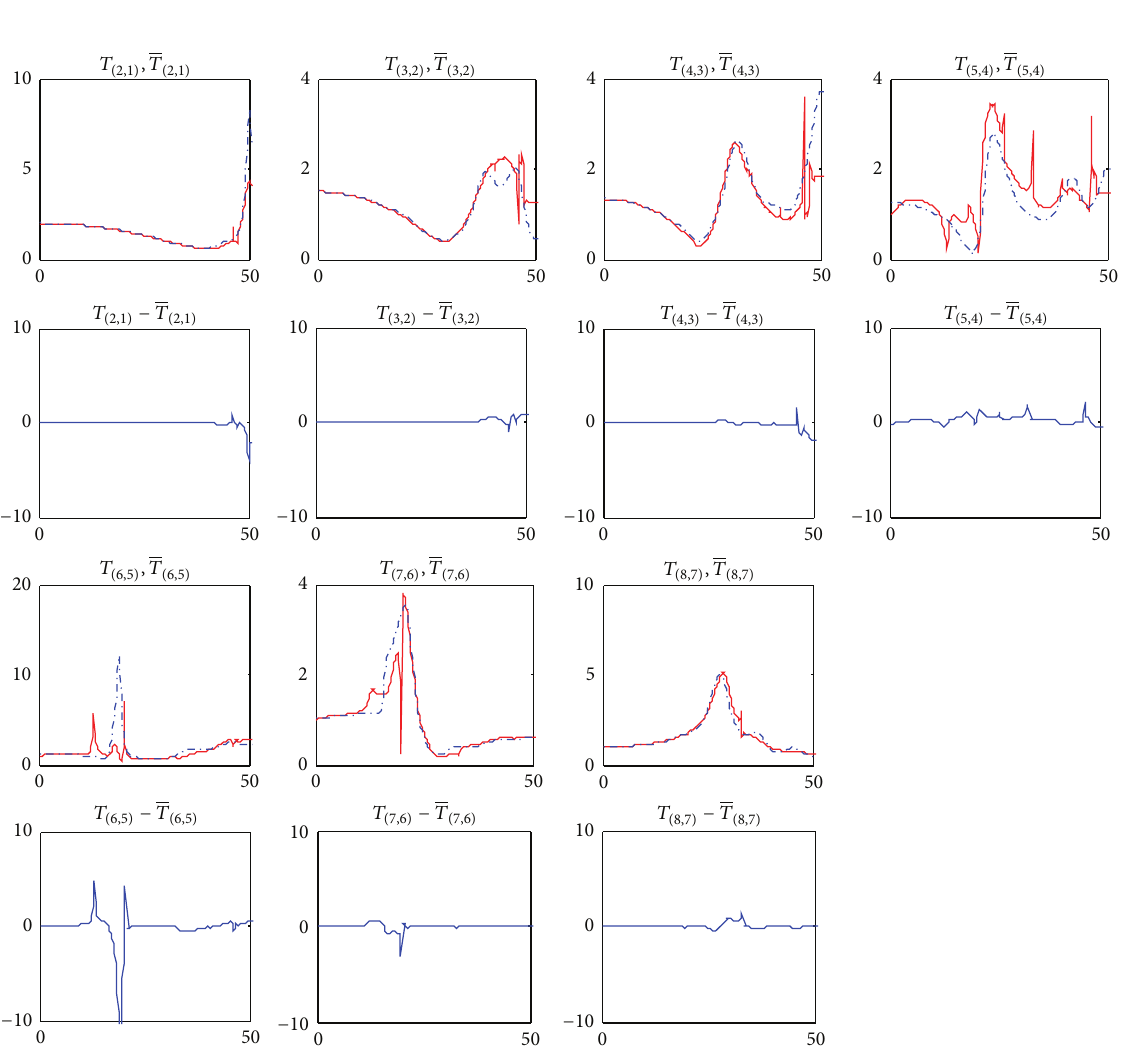
Figure 4: TFs of the system with bilinear component before and after the variation and their difference versus frequency (Hz): blue— 𝑇 (𝑖+ 1 ,𝑖) , red— 𝑇 (𝑖+ 1 ,𝑖)